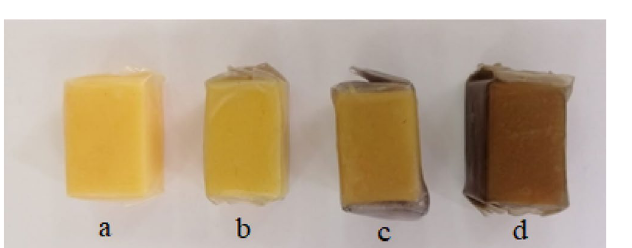
Figure 2. Experimental samples of hard cheese “Holland” packed in methylcellulose films modified with CuO nanoparticles: ( a ) control, ( b ) 0.2%, c 0.4%, ( d )